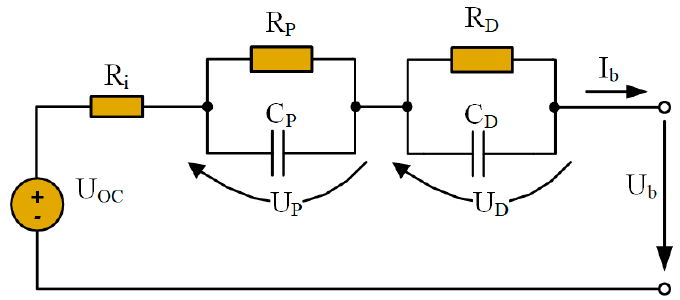
Figure 2. LiFePO 4 (LFP) battery cell equivalent circuit model.